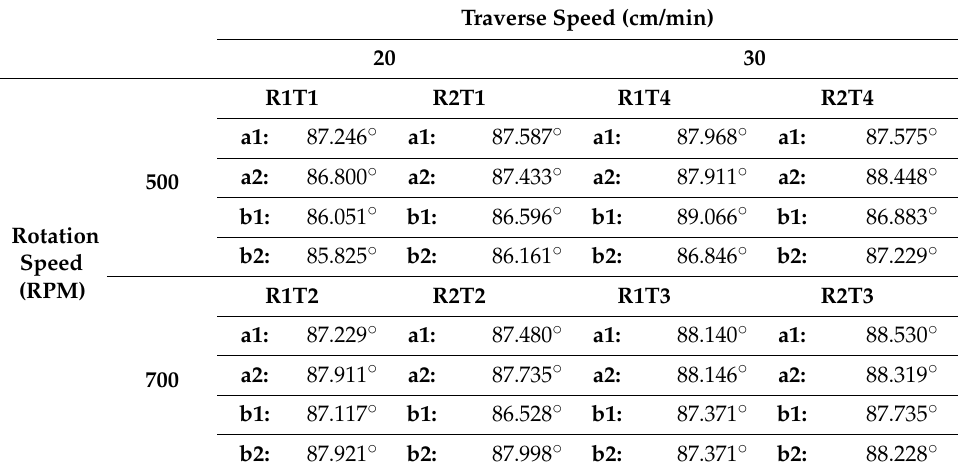
Table 4. Values of MSHC for each test.